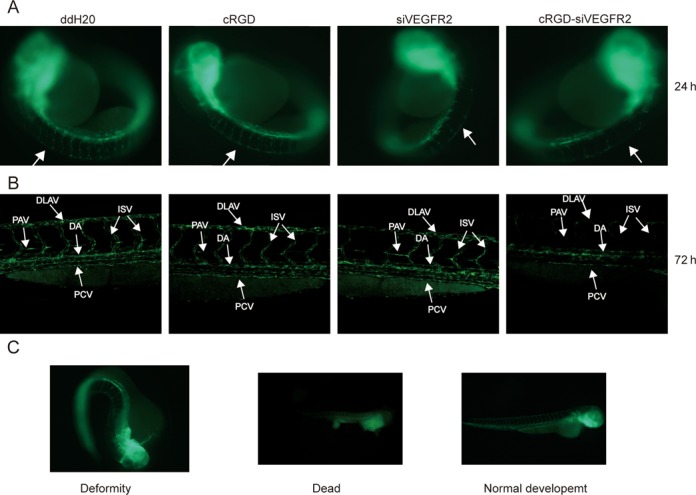
Anti-angiogenic effect of cRGD-siRNA in zebrafish. (A) The 5 hpf Tg(flk1:EGFP) zebrafish embryos were injected with either water (ddH20), cRGD peptide alone (cRGD), non-conjugated VEGFR2 targeting siRNA (siVEGFR2) or VEGFR2 cRGD-siRNA. Twenty-four hours after microinjection, angiogenesis in the whole embryos was visualized and imaged using Stereo Fluorescence Microscope. Arrows indicate the places of possible inhibition of trunk vascular development in animal treated with cRGD-siRNA (right panel) and corresponding places in control animals. (B) Animals treated as above were visualized for vasculature development using confocal microscopy 72 h after microinjections. Arrows indicate defective trunk vessel formation in animals treated with cRGD-siVEGFR2 (right panel) versus control group animals (three left panels): the barely visible inter-segmental vessels (ISV), dorsal longitudinal anastomotic vessels (DLAV), posterior cardinal vein (PCV) and parachordal vessels (PAV), as well as failure of a fraction of ISVs to branch off from the dorsal aorta (DA). (C) After injection of the 5 hpf zebrafish embryos with cRGD-siVEGFR2, during the 72 h observation period, majority of the animals developed into larvae normally (exemplified on the right panel). However, 15% of the animals developed abnormal phenotypes (exemplified on the left panel) and 10% of the animals died (exemplified on the middle panel).